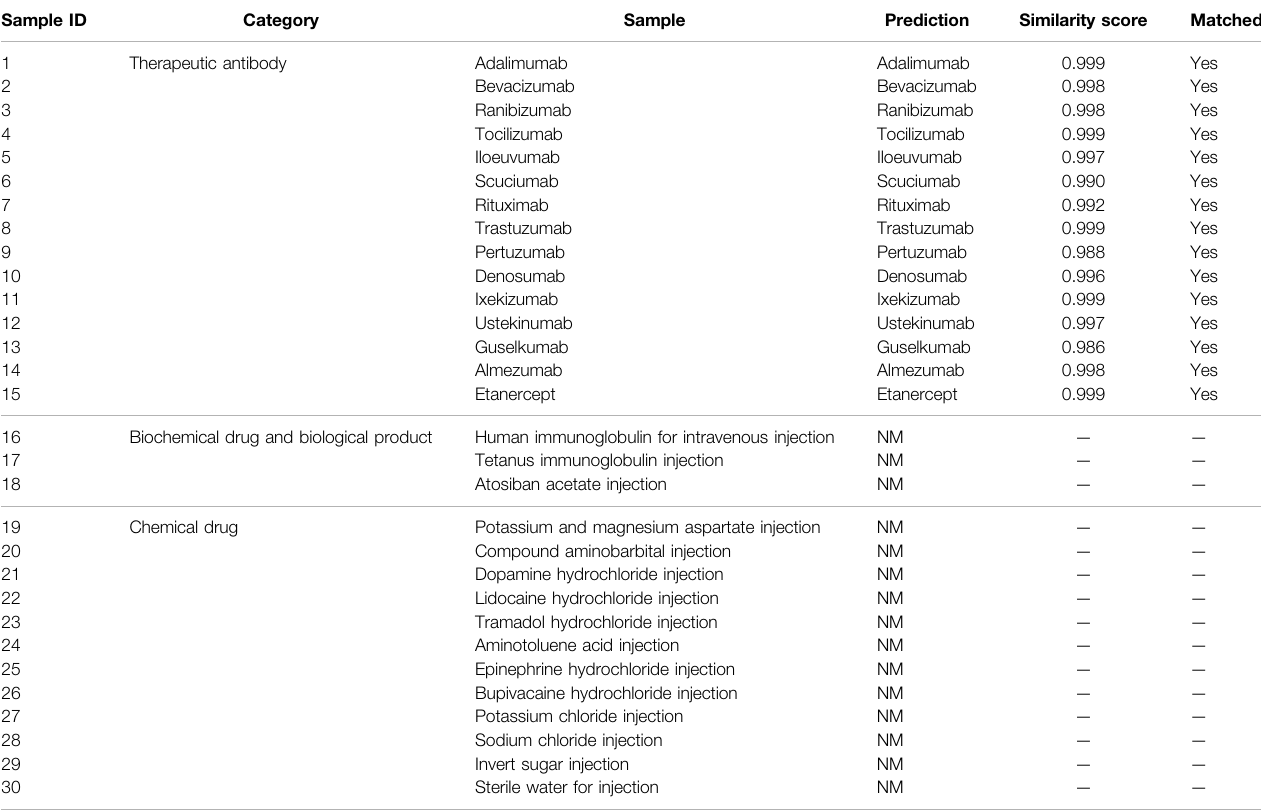
TABLE 2 | Application of the presented method to identify 30 injections, including 15 monoclonal antibodies and 15 other